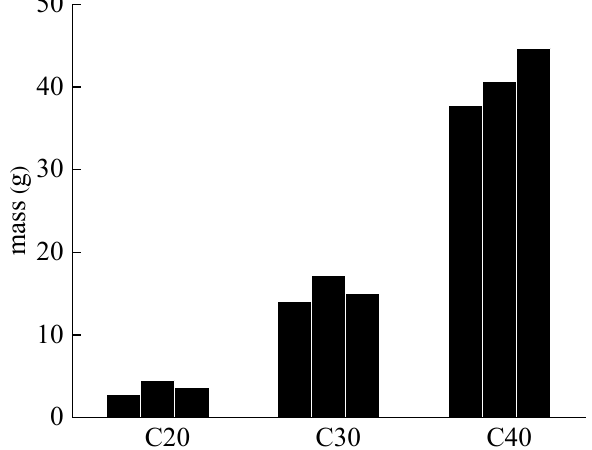
Figure 6. The mass of the powdery precipitated substances at di ff erent water–cement ratios. Three samples were tested for each water–cement ratio.